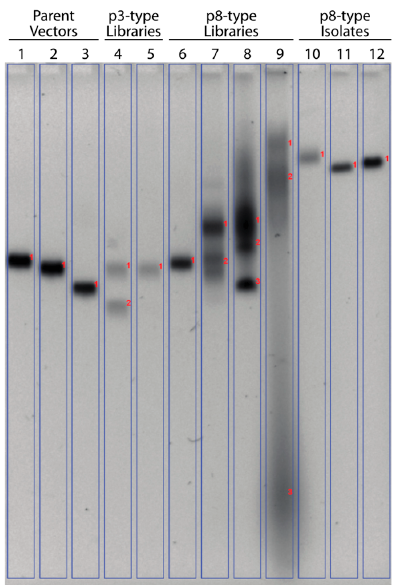
Figure 3. Migration of intact phages in gel electrophoresis. Relative mobility of intact filamentous phage display libraries and isolated phage clones by electrophoresis through an agarose gel. Parent